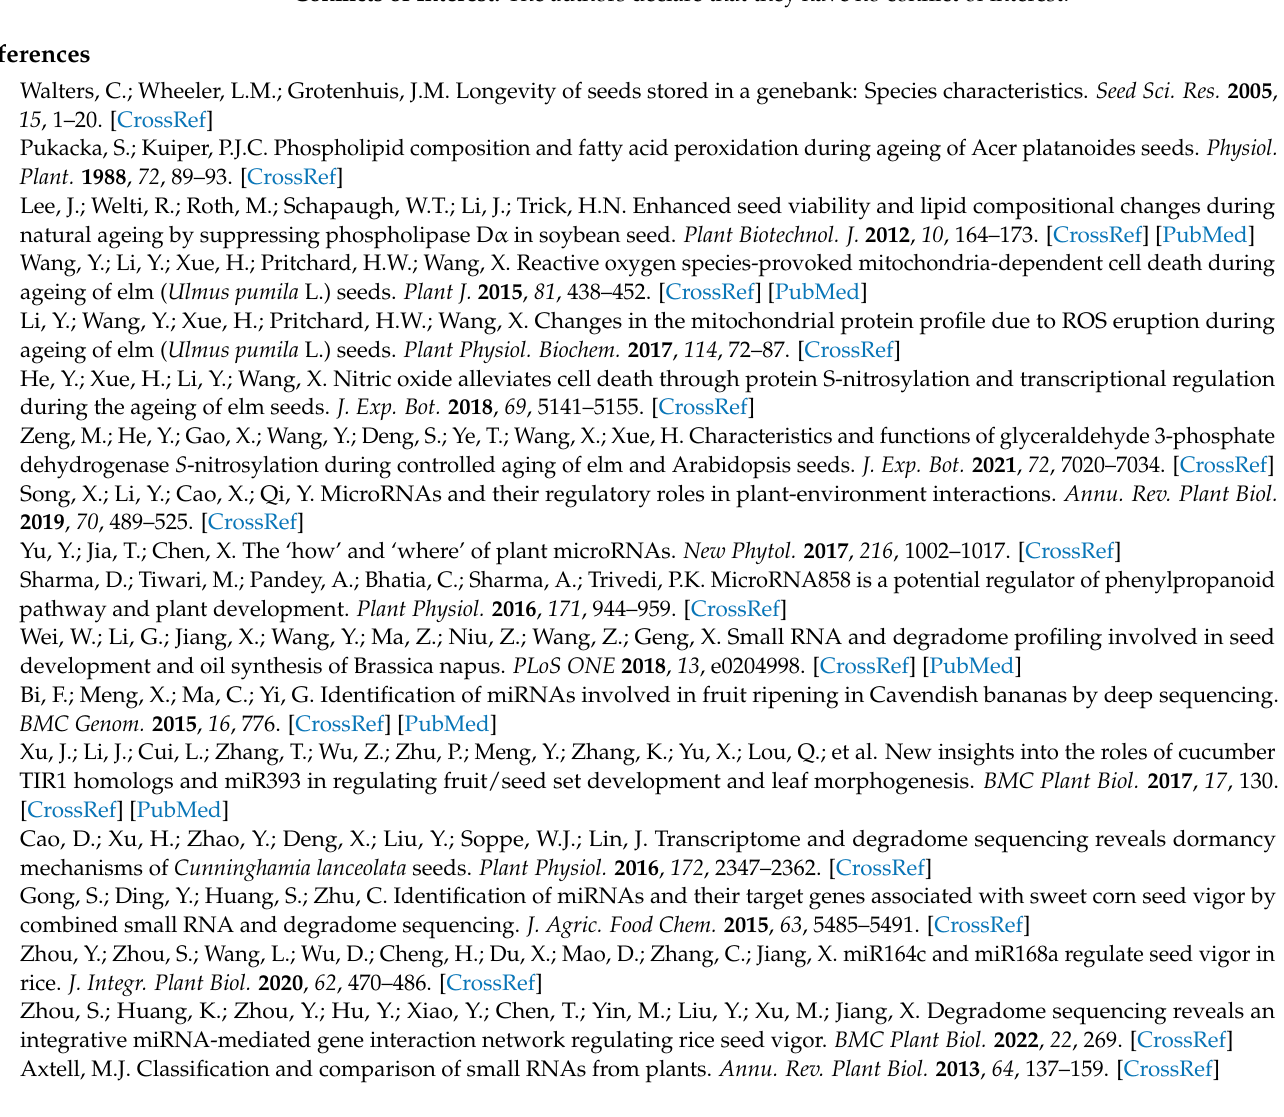
Table S1: Summary of illumina sequencing for aging elm seeds; Table S2: Statistics of small RNA libraries analyzed by high-throughput sequencing; Table S3: Statistics of identified novel miRNAs; TableS4: Comparison of differentially expressed genes (DEGs) in different groups; Table S5: Target genes predicted of conservative miRNA and novel miRNA by GSTAr v1.0 and degradome sequencing; Table S6: Primer